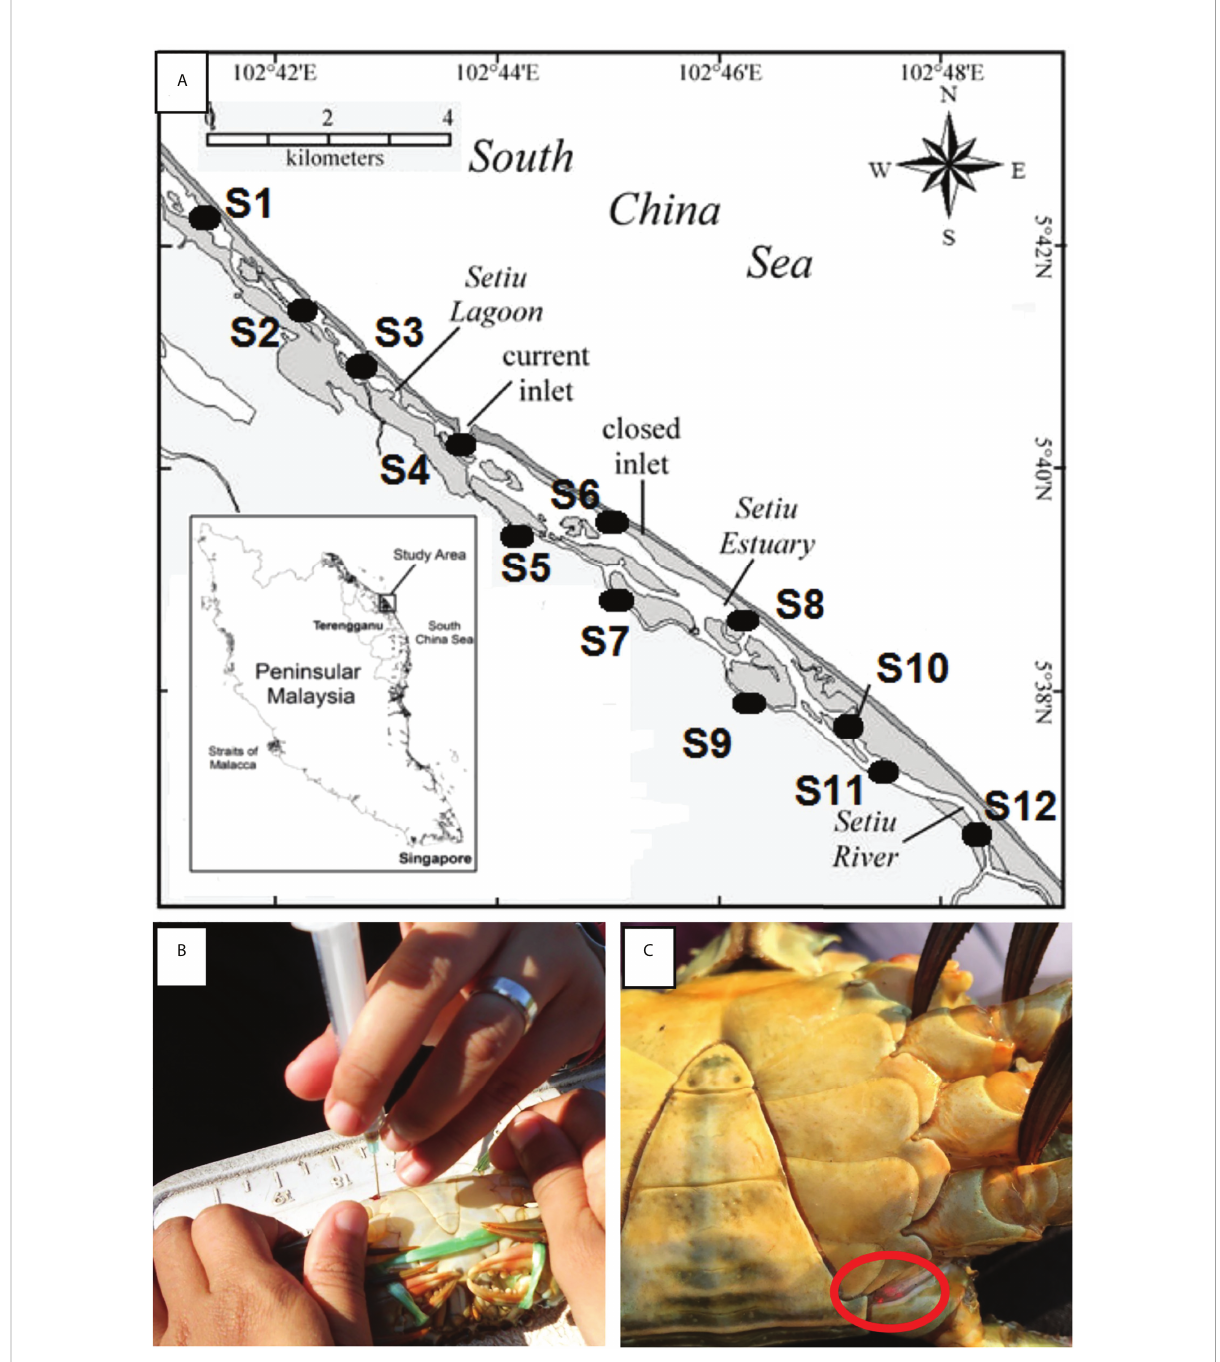
FIGURE 1 (A) Location of sampling stations in Setiu Wetland, Terengganu, bordering the South China Sea. The stations were divided into (1) mangrove forests – Station 5, 7, 9, 10; (2) Estuaries – Station 3, 4, 6, 8; and (3) river channels – Station 1, 2, 11, 12. Mangrove forests are characterized by the presence of mangrove trees, estuaries are wetlands surrounding by bodies of brackish water, and river channels are characterised by the presence of river banks and beds, with lower salinity compared to estuaries; (B) Tagging of crab sample at the joint of appendage using orange VIE tag; (C) The presence of orange VIE tag on recaptured